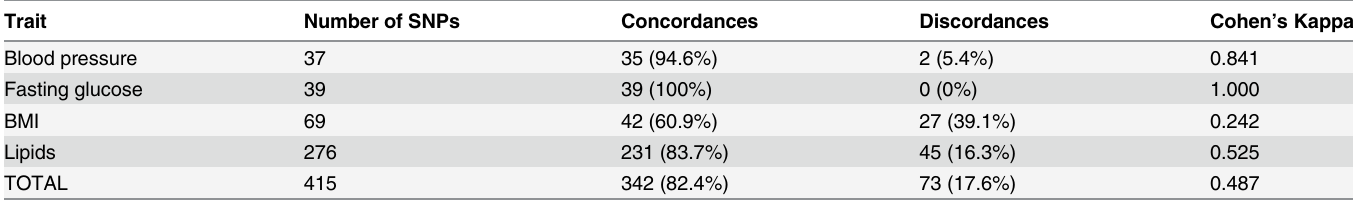
Table 2. Summary of discordances between outputs from SNAP (the 1000 Genomes reference) and the Illumina Cardio-Metabochip fi le.